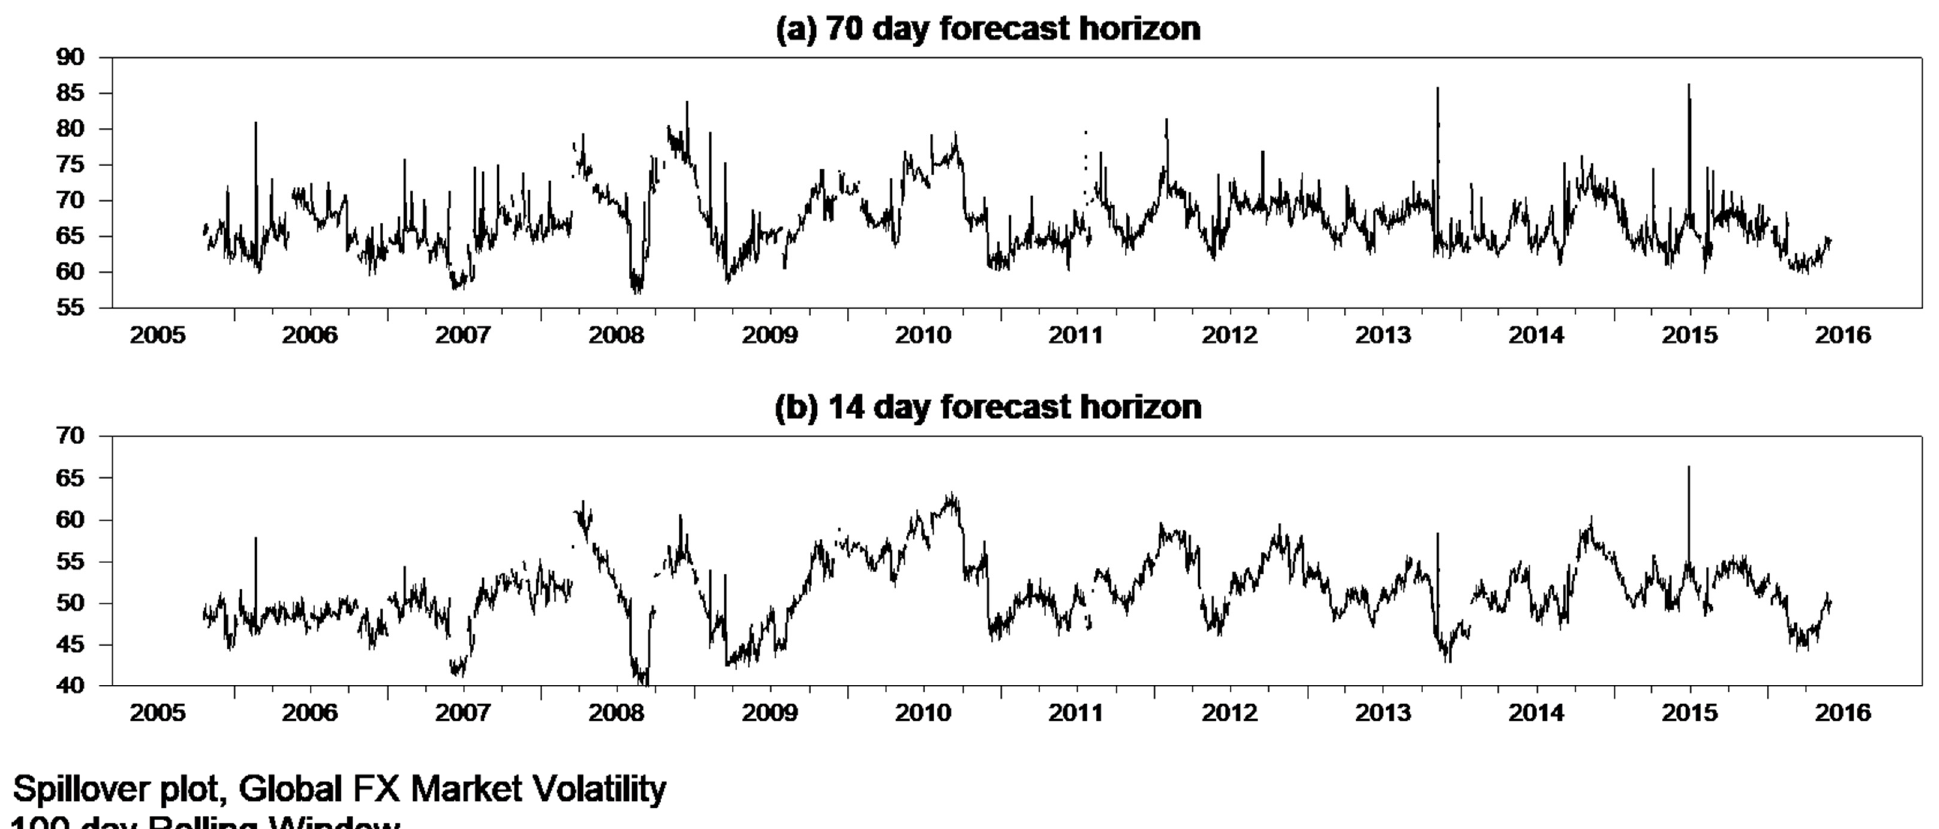
Figure 3. Spillover plots. Global foreign exchange markets (2005–2016), 70- and 14-day forecast horizons.